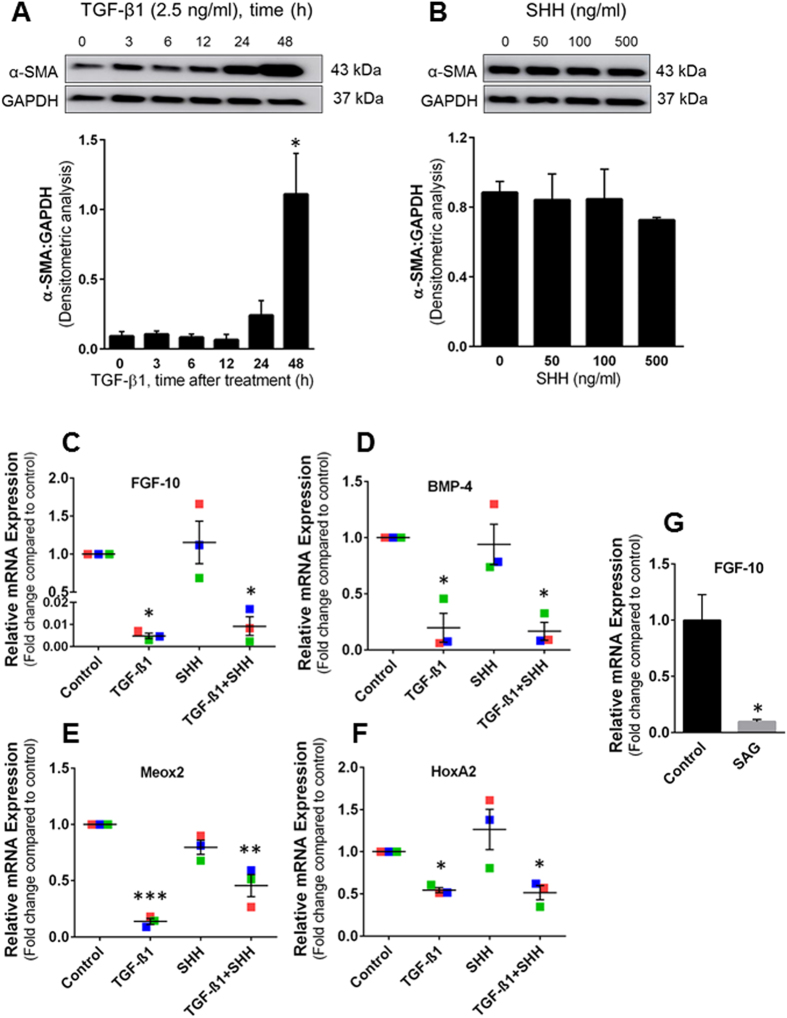
Effects of TGF-β1, SHH and SAG on BAL-derived MSCs.(A,B) Myofibroblast differentiation. MSCs were isolated from surveillance bronchoscopies and BAL from lung transplant recipients without bronchiolitis obliterans or infection. MSCs were seeded in 6-well tissue culture plates and serum deprived for 24 h followed by either TGF-β1 treatment (2.5 ng/ml) or SHH (0, 50, 100, 500 ng/ml) for 48 h. Cell lysates were prepared in RIPA buffer and subjected to SDS-PAGE and western blot analysis for α-SMA; GAPDH antibody was used as loading control. Densitometry was performed to quantitate the ratio of α-SMA and GAPDH and plotted graphically; bar graphs represent mean ± SEM, n = 3; *p < 0.05, compared to vehicle treated control. Full-length western blots are presented in Supplementary Figure S6. (C–F) RNA expression of developmental genes of interest. Total RNA was isolated from MSCs 48 h post-treatment with either TGF-β1 or SHH or combination and subjected to real-time PCR analysis. Data were normalized to 18 S rRNA and relative mRNA expressions are represented graphically as fold change compared to control. Data represents mean ± SEM; n = 3 (each analyzed in triplicate); *p < 0.01; **p < 0.001; ***p < 0.0001. Individual colored marker represents average relative mRNA expression of single lung transplant recipient. (G) The smoothened agonist, SAG, downregulates FGF-10. MSCs were treated with vehicle and SAG (100 ng/ml) for 48 h; total RNA was extracted and subjected to real-time PCR analysis. Data were normalized to 18 S rRNA and relative mRNA expressions represented graphically as fold change compared to control. Data represents mean ± SEM; n = 3, *p < 0.01.